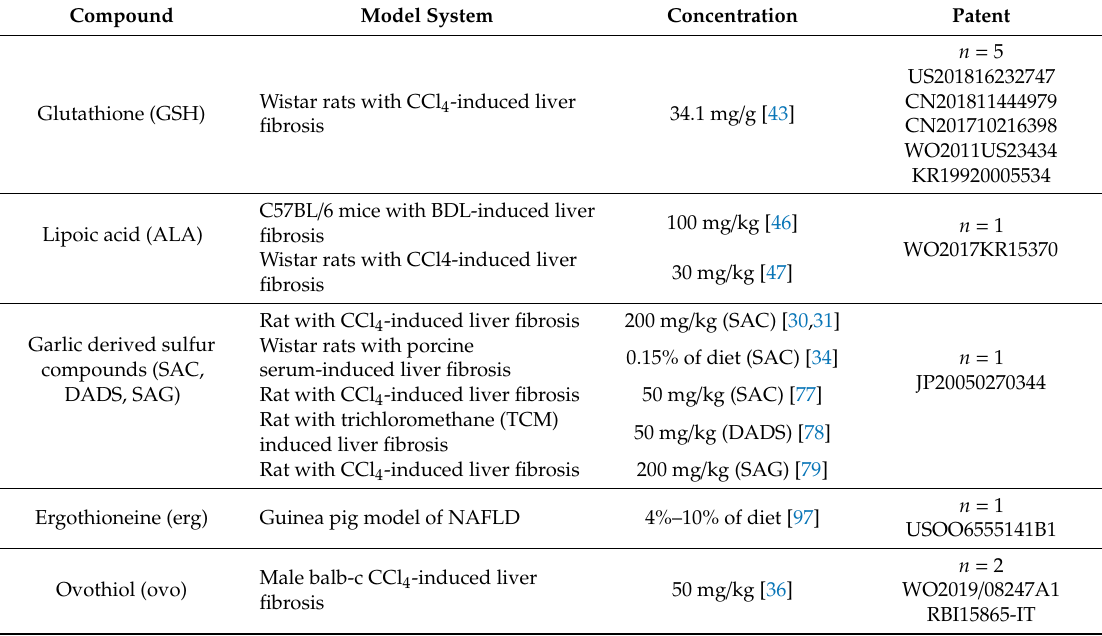
Table 1. Therapeutic e ffi cacy of sulfur-containing compounds in liver fibrosis models. The name of compounds, the experimental models, the doses, and the related patents are